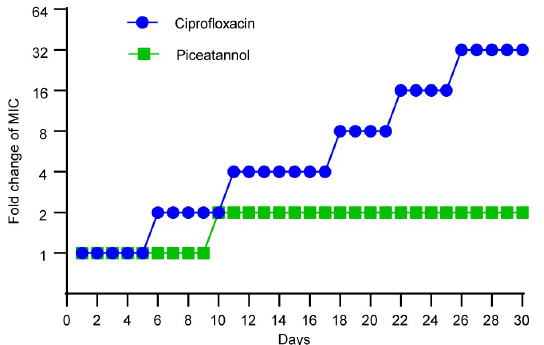
Figure 7. Resistance selection studies of PIC against S. aureus ATCC 29213. n = 3. Results from all experiments are presented as the mean ± SD of three replicates.